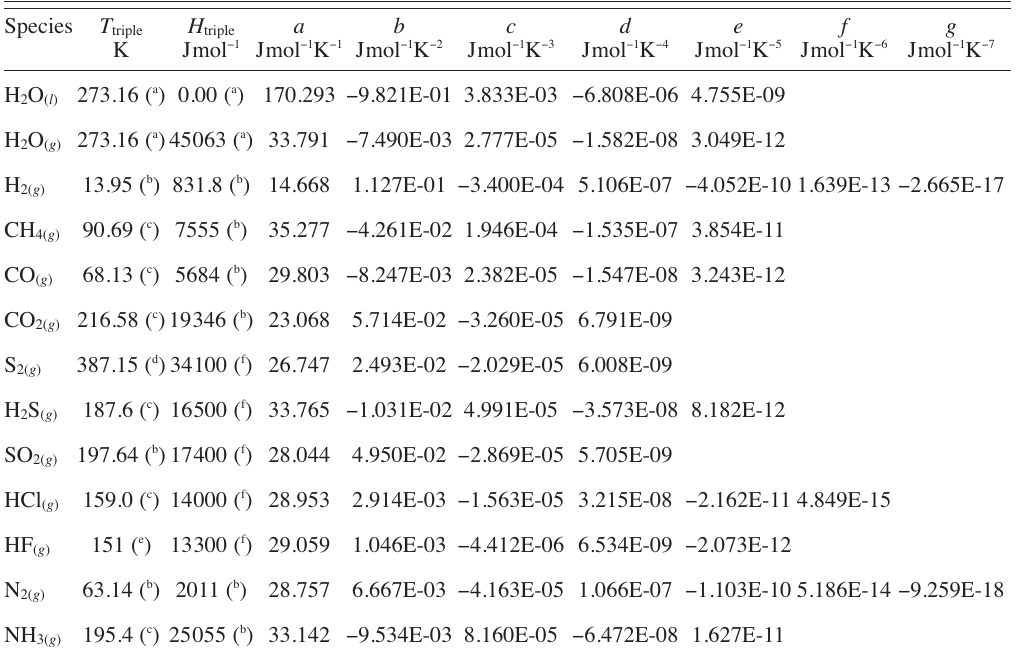
Table II. Triple point temperature, enthalpy at the triple point, and coefficients of the empirical power series in the temperature, which were used in this work to fit the molar heat capacity of relevant gas species and liq- uid water ( C P data from Chase,